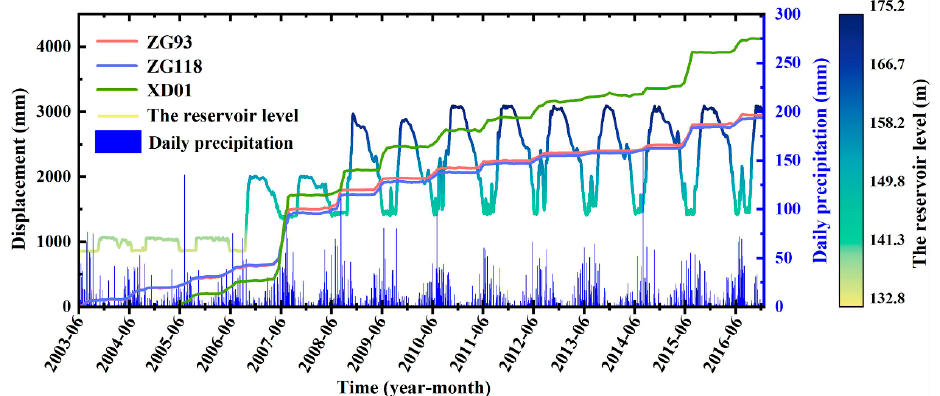
Figure 8. Long term monitoring data of the Baishuihe landslide (displacement, reservoir level, precipitation).